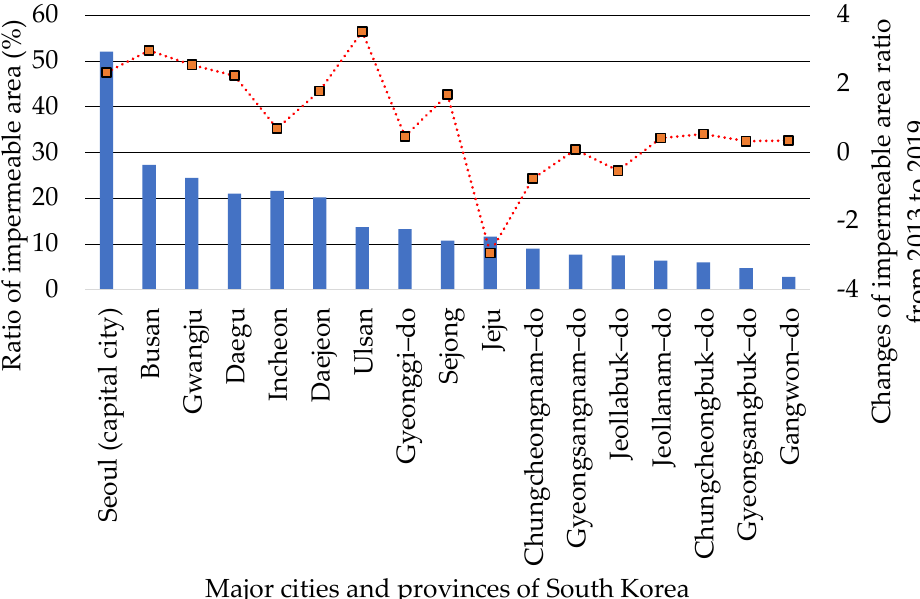
Figure 2. Ratio of impermeable area and its changes for 7 yrs. (from 2013 to 2019) in major cities and provinces.